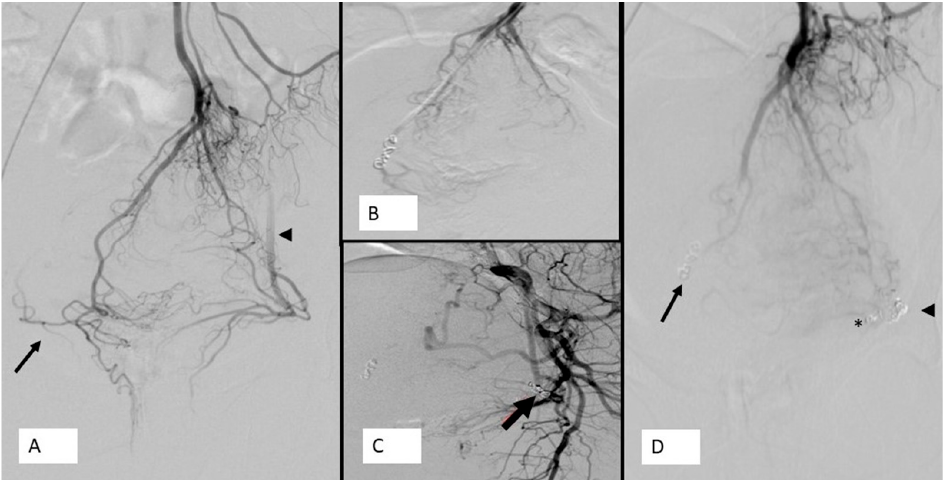
Figure 2. Forty-three-year-old lady, weight lifter, suffering from grade III bleeding hemorrhoids: ( A ) Angiogram of SRA showing a type IV vascularization according to the Thomson classification After the coiling of left lateral branch of SRA (arrow), a selective angiogram of left internal iliac artery showing a patent left MRA. ( B ) Coiling of right lateral branch of SRA (arrow). ( C ) of the CCR feeding artery below the pubic symphysis. ( D ) The final angiogram of SRA showing coiling of right lateral branch of SRA (arrow), coiling of left MRA (asterisk), and coiling of left lateral branch of SRA (arrowhead), with occlusion with evidence of retrograde filling of right MRA (arrow) and left MRA (arrowhead). Note the diameter of left MRA is equal to that of the SRA. The frequency of the middle rectal artery is reported to range from 12 to 97% and